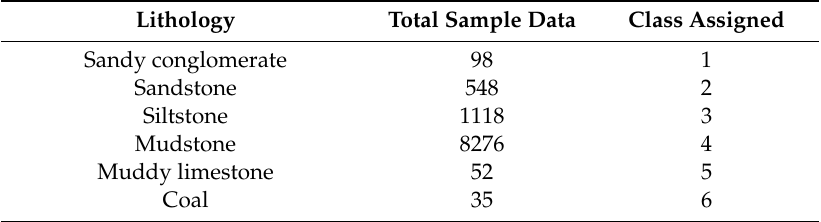
Figure 1. ( a ) The map showing the location of the South Yellow Sea. ( b ) The location of the well in the southern basin of the South Yellow Sea. ( c ) The lithology of the southern basin of the South Yellow Sea. Table 1. Details of the lithology data used in this